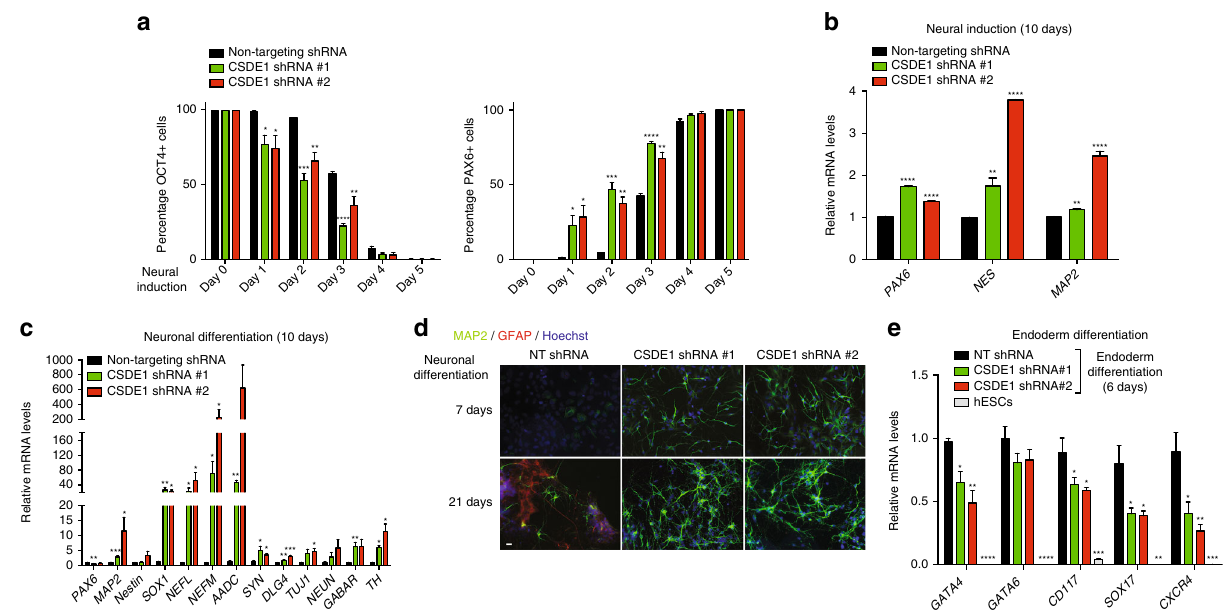
Fig. 4 Loss of CSDE1 promotes neural differentiation and neurogenesis. a Percentage of OCT4 and PAX6-positive cells/total nuclei at different days after neural induction of undifferentiated H9 hESC colonies (mean ± s.e.m. of three independent experiments, 200 total cells per experiment). b qPCR analysis after 10 days of neural induction. Data (relative expression to NT shRNA cells) represent two independent experiments with three biological replicates. c qPCR analysis of neuronal markers after 10 days of pan-neuronal differentiation. Graph (relative expression to NT shRNA) represents the mean ± s.e.m. of three independent experiments with three biological replicates. d Immunocytochemistry after 7 and 21 days of neuronal induction. MAP2, GFAP, and Hoechst staining were used as markers of neurons, astrocytes, and nuclei, respectively. Scale bar represents 20 μ m. e qPCR analysis of endoderm markers upon de fi nitive endodermal differentiation of undifferentiated H9 hESCs. Graph (relative expression to NT shRNA) represents the mean ± s.e.m. of three independent experiments with two biological replicates. All the statistical comparisons were made by Student ’ s t-test for unpaired samples. P -value: *( P < 0.05), **( P < 0.01), ***( P < 0.001), **** ( P <